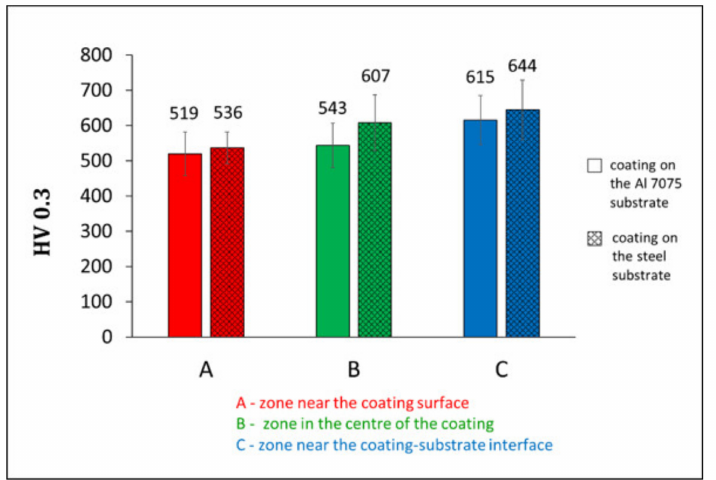
Figure 10. The HV0.3 hardness measured in three zones of cermet coatings deposited on the Al alloy and steel